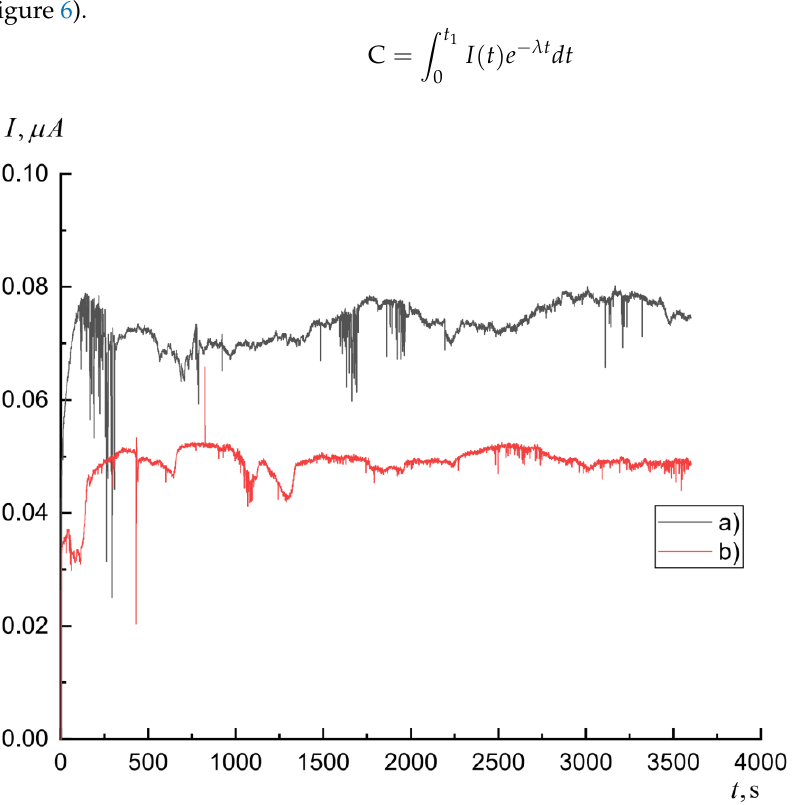
Figure 6. Accelerator current during irradiation of nat Ni ( a ) and 60 Ni ( b ) . Yields of reactions on 58 Ni were calculated as a difference between the yields of iso- tope production on natural mix and on 60 Ni, taking into account the percentage of 58 Ni and 60 Ni in natural mix. The accuracy of the selected calculation method was confirmed by the ratio of formation yields after the irradiation of 60 Ni and nat Ni (3.85 ± 0.05) coin- cided within the margin of error with the ratio of 60 Ni content in